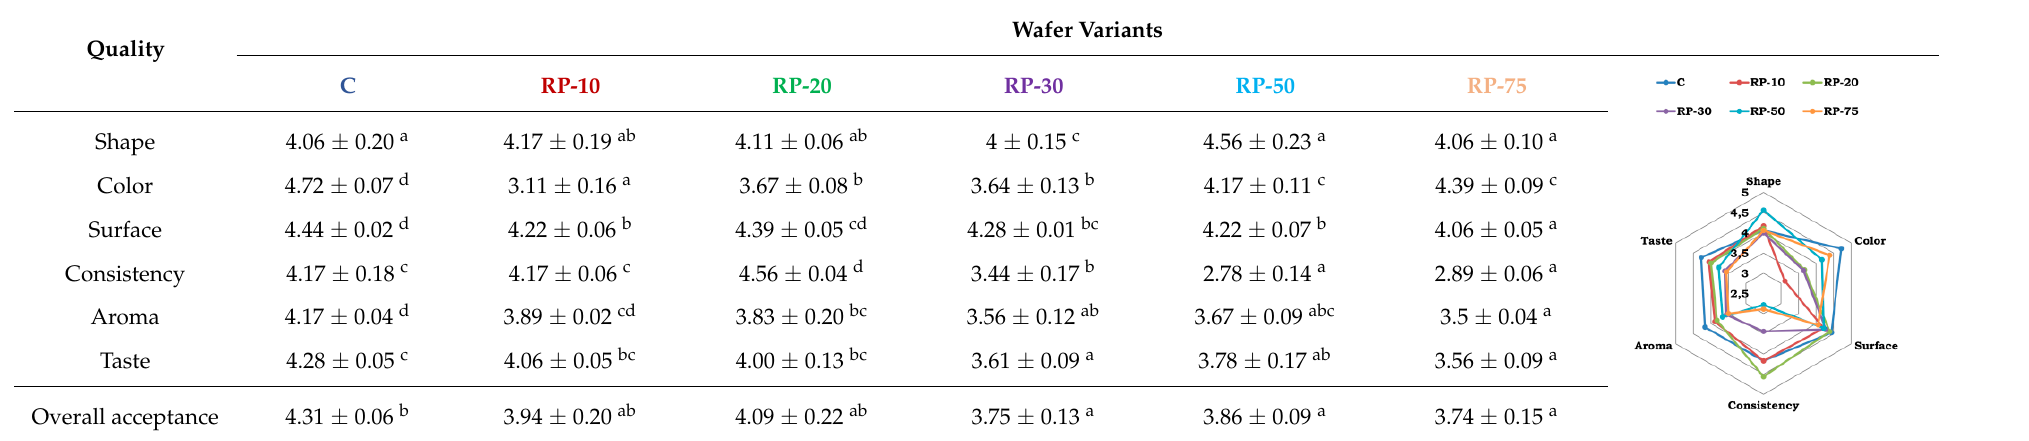
Table 2. Sensory values of the control and fortified wafers.